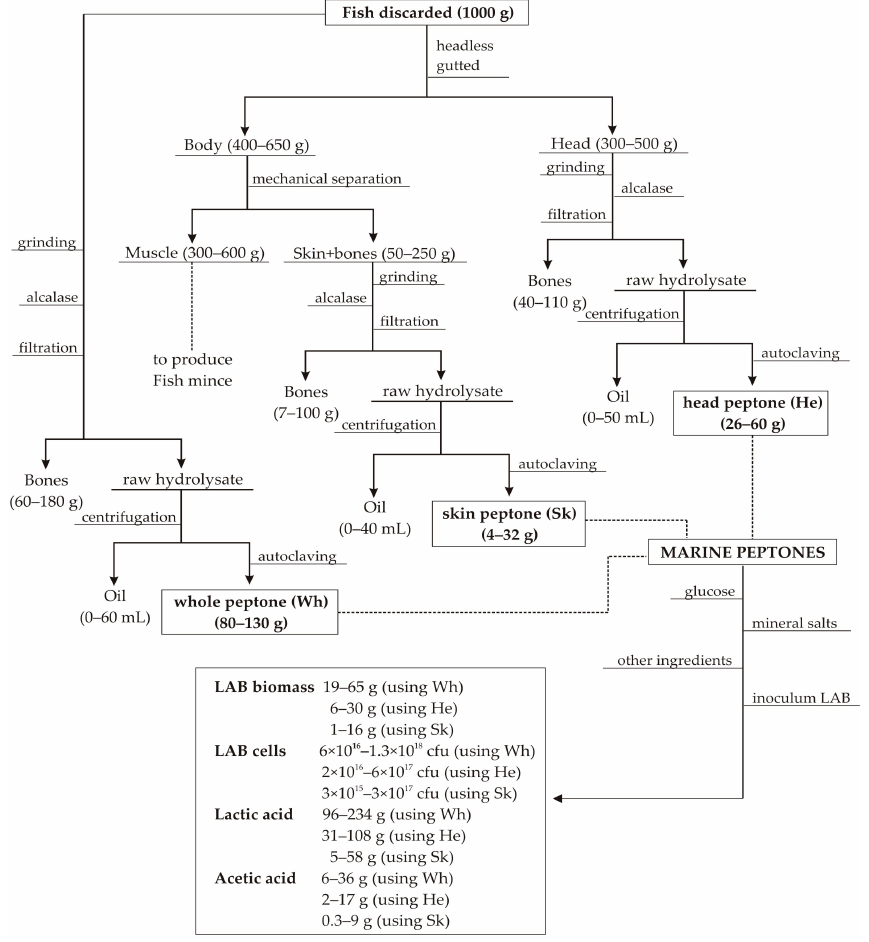
Figure 1. Flowchart of steps involved in the production of peptones from skin, head, and whole individuals of discarded fish by fishing fleets, and their application for the production of LAB and metabolites. The mass balances, employing 1000 g of fish discarded as calculation basis, are also